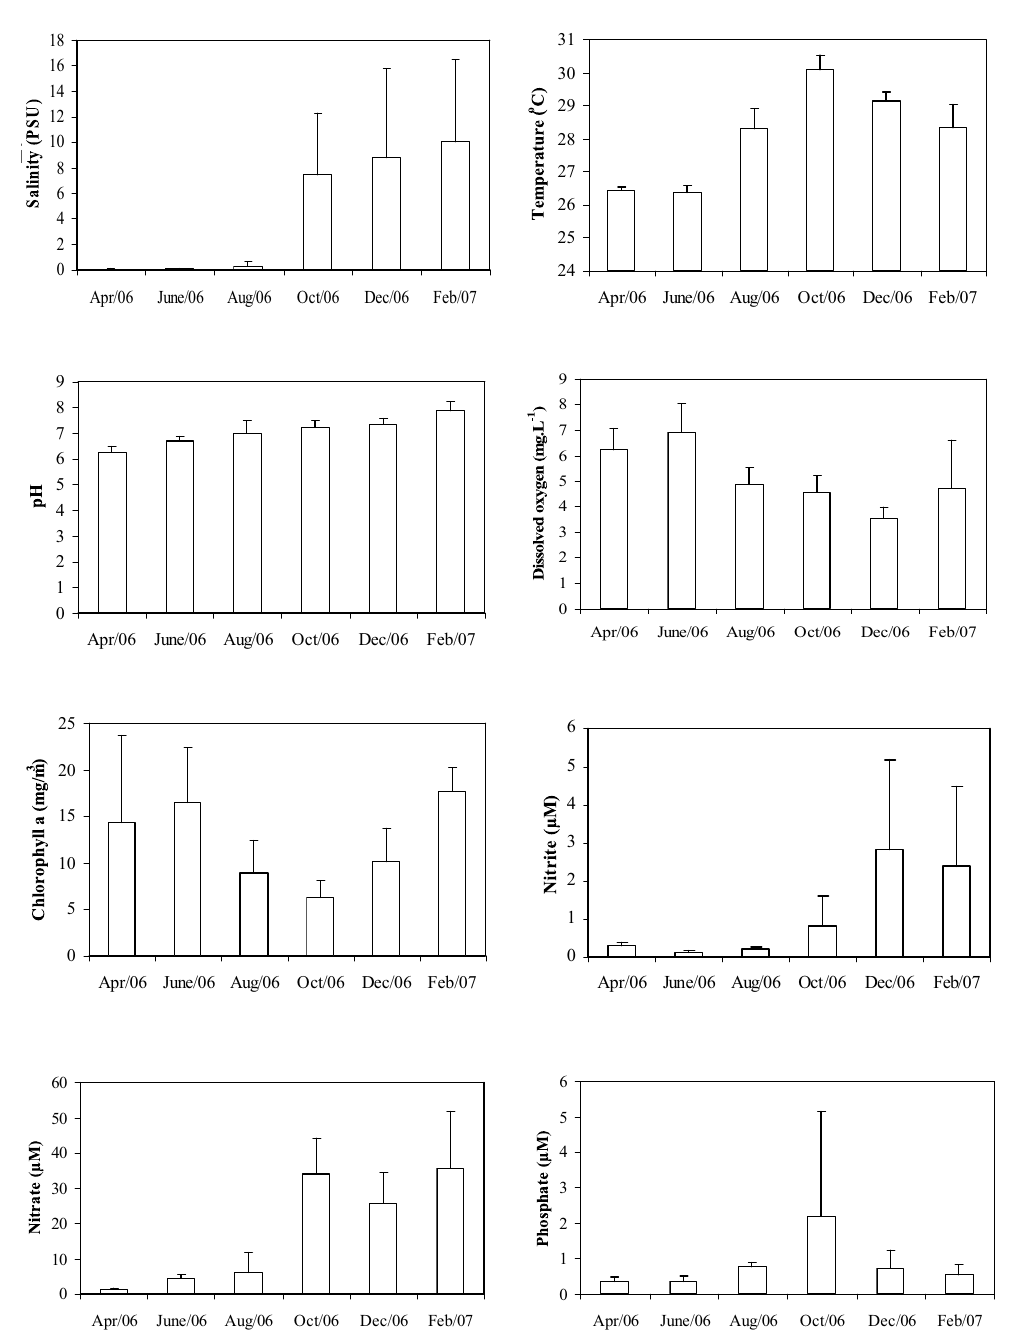
Fig. 3 – Mean hydrological values between April/06 and February/07, in the Caeté